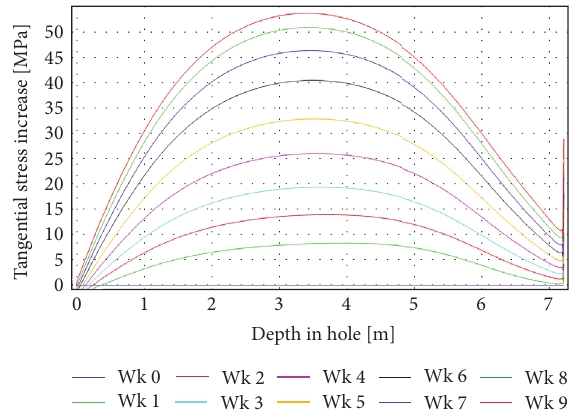
Figure 10: Calculated tangential stress at the inner surface of the concrete liner (weeks